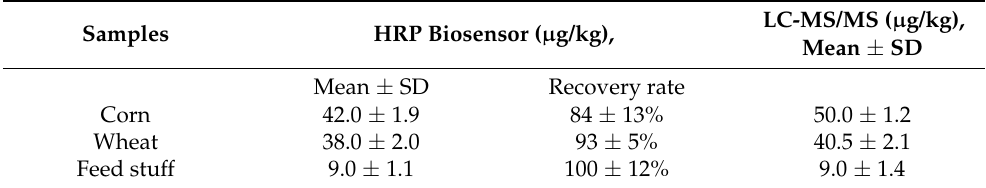
Table 2. Recovery of Ochratoxin A levels in corn, wheat, and feed using LC-MS/MS and the fabricated